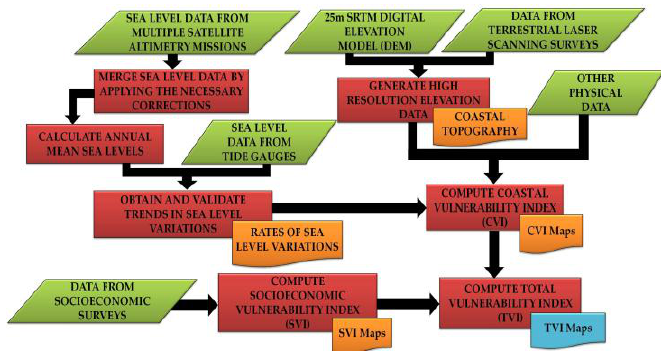
Figure 2. The vulnerability assessment